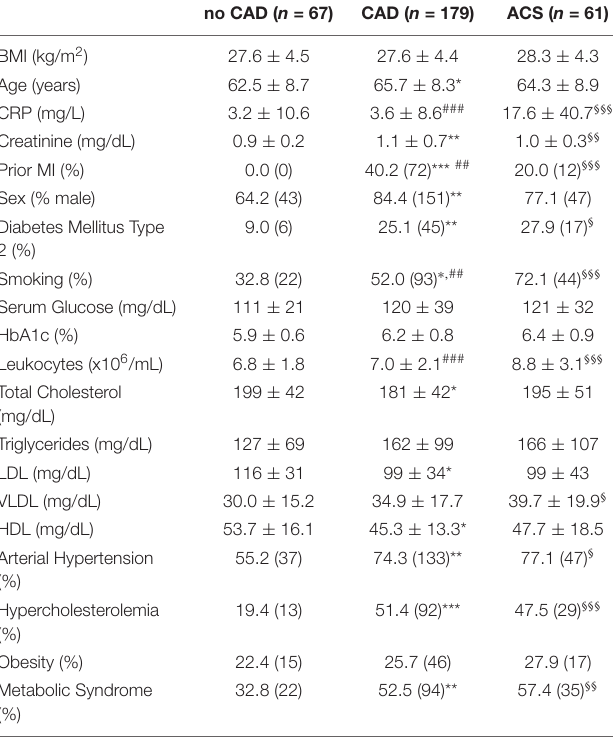
TABLE 1 | Clinical characteristics of the TRAFIC study